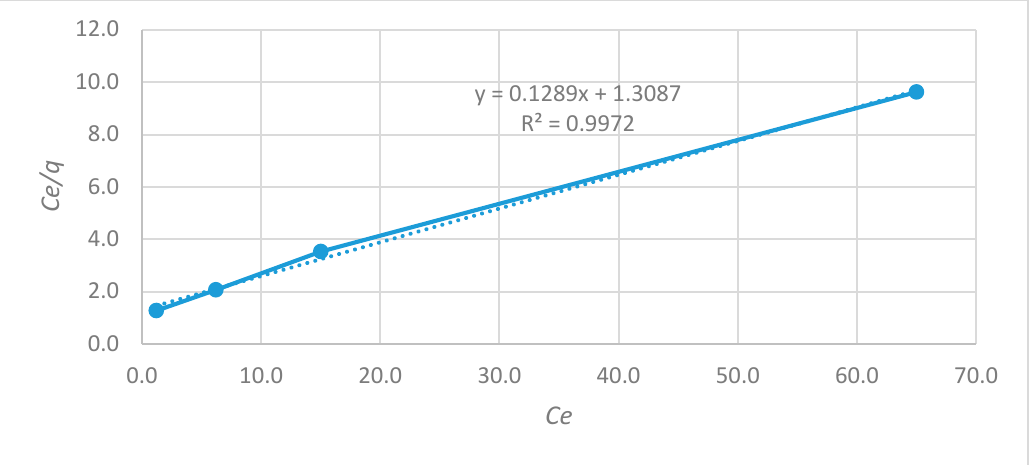
Figure 4. Langmuir isotherm EC.